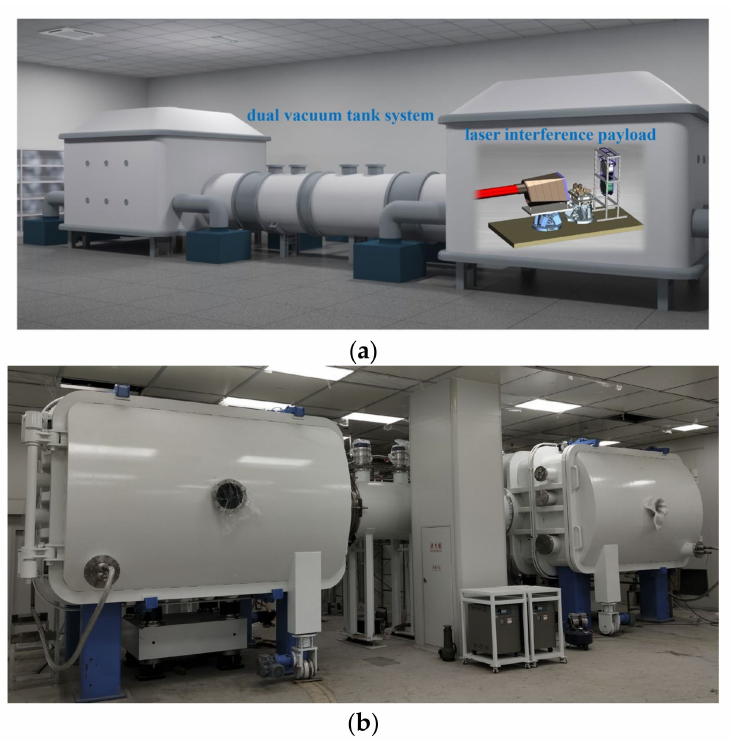
Figure 13. Experimental scenario for the semi-physical simulation test: ( a ) the experimental scenario; ( b ) the dual vacuum tank system under